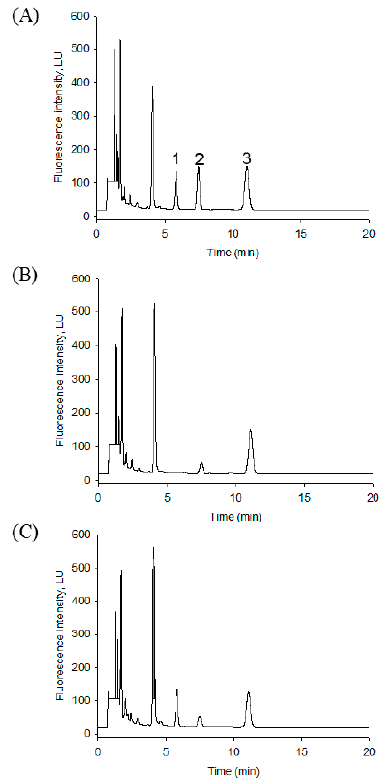
Figure 3. Typical HPLC–FLD chromatograms. Profile of 5,5-dimethyl CHD derivatives of ( A ) 100 pmol of pentadecanal, hexadecanal, and the heptadecanal standard solution. ( B ) Blank cell lyases with 100 pmol heptadecanal. ( C ) F9-4 cell S1PL activity after solid-phase extraction (SPE) and C18 reverse-phase HPLC–FLD with 90% methanol and 0.1% acetic acid as the elution. The SPE extrac- tion yield was above 85%. 1: pentadecanal; 2: hexadecanal; 3: heptadecanal.